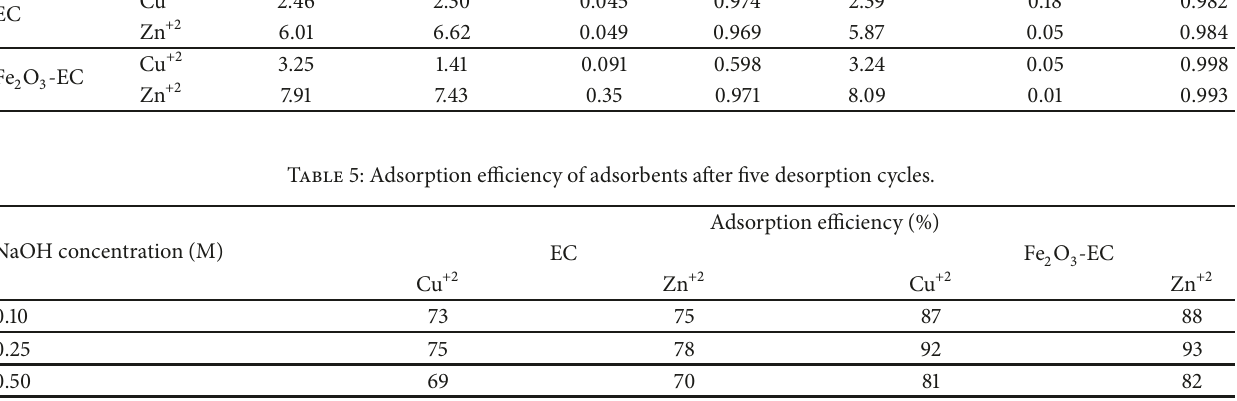
Table 4: First- and second-order kinetic parameters for metal ion adsorption on biochars. Pseudo- 1 st order Adsorbent